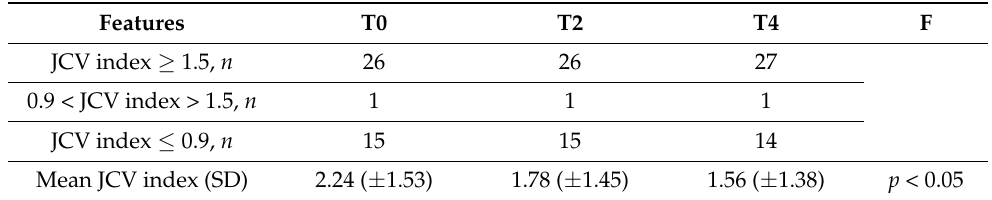
Table 4. JCV index in MS